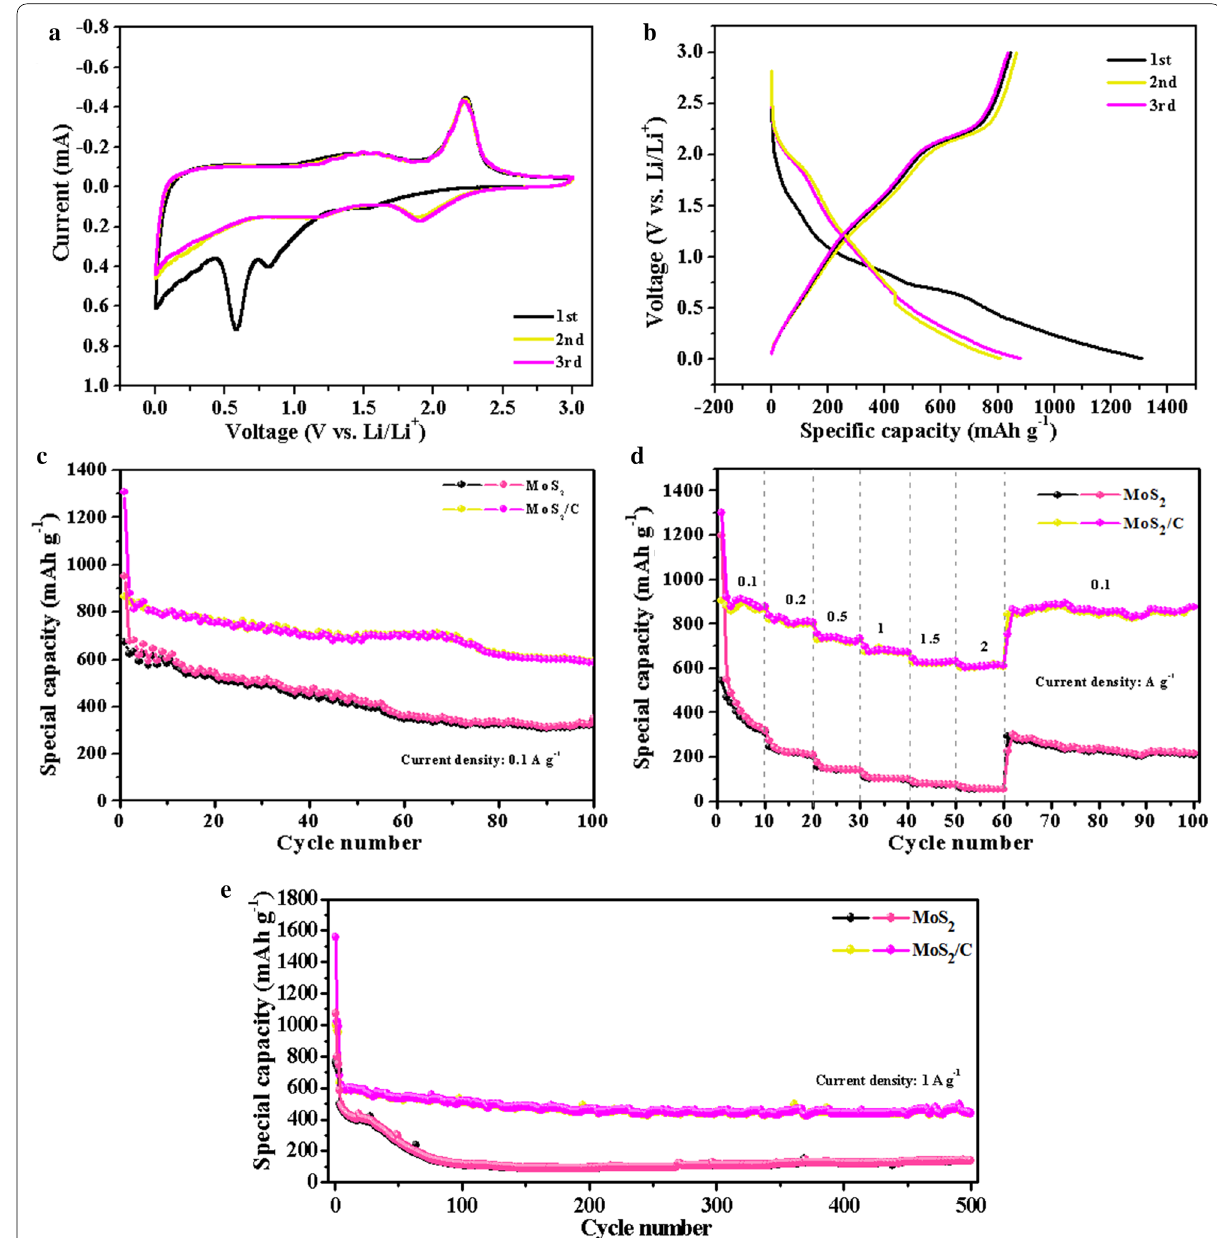
Fig. 5 a CV curves at scan rate 0.2 mV s − 1 between 0 and 3 V and b discharge/charge profiles at a current density of 0.1 A g − 1 of MoS 2 /C nanospheres; c the cycling performance of